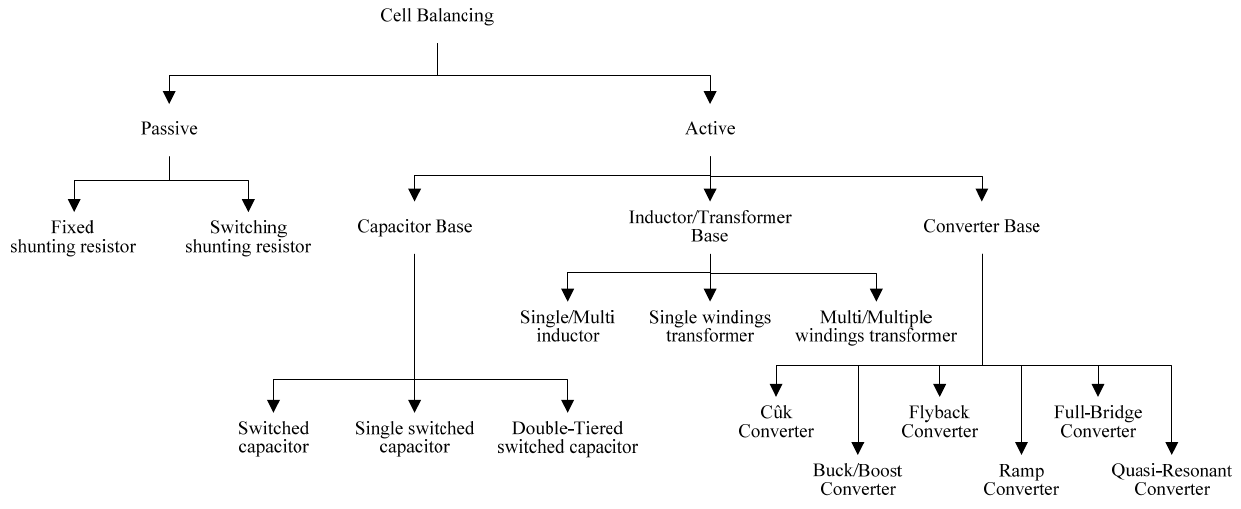
Figure 1. Passive and active cell balancing topologies [1]. Reprinted/Reproduced with permission from 2011